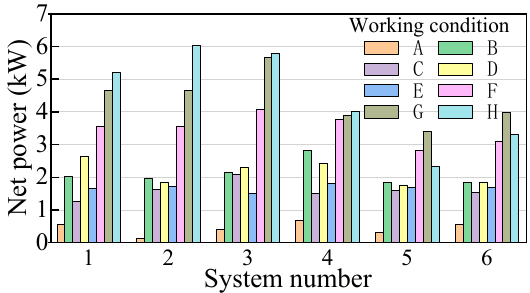
Figure 17. Net power of each system under 25 °C.